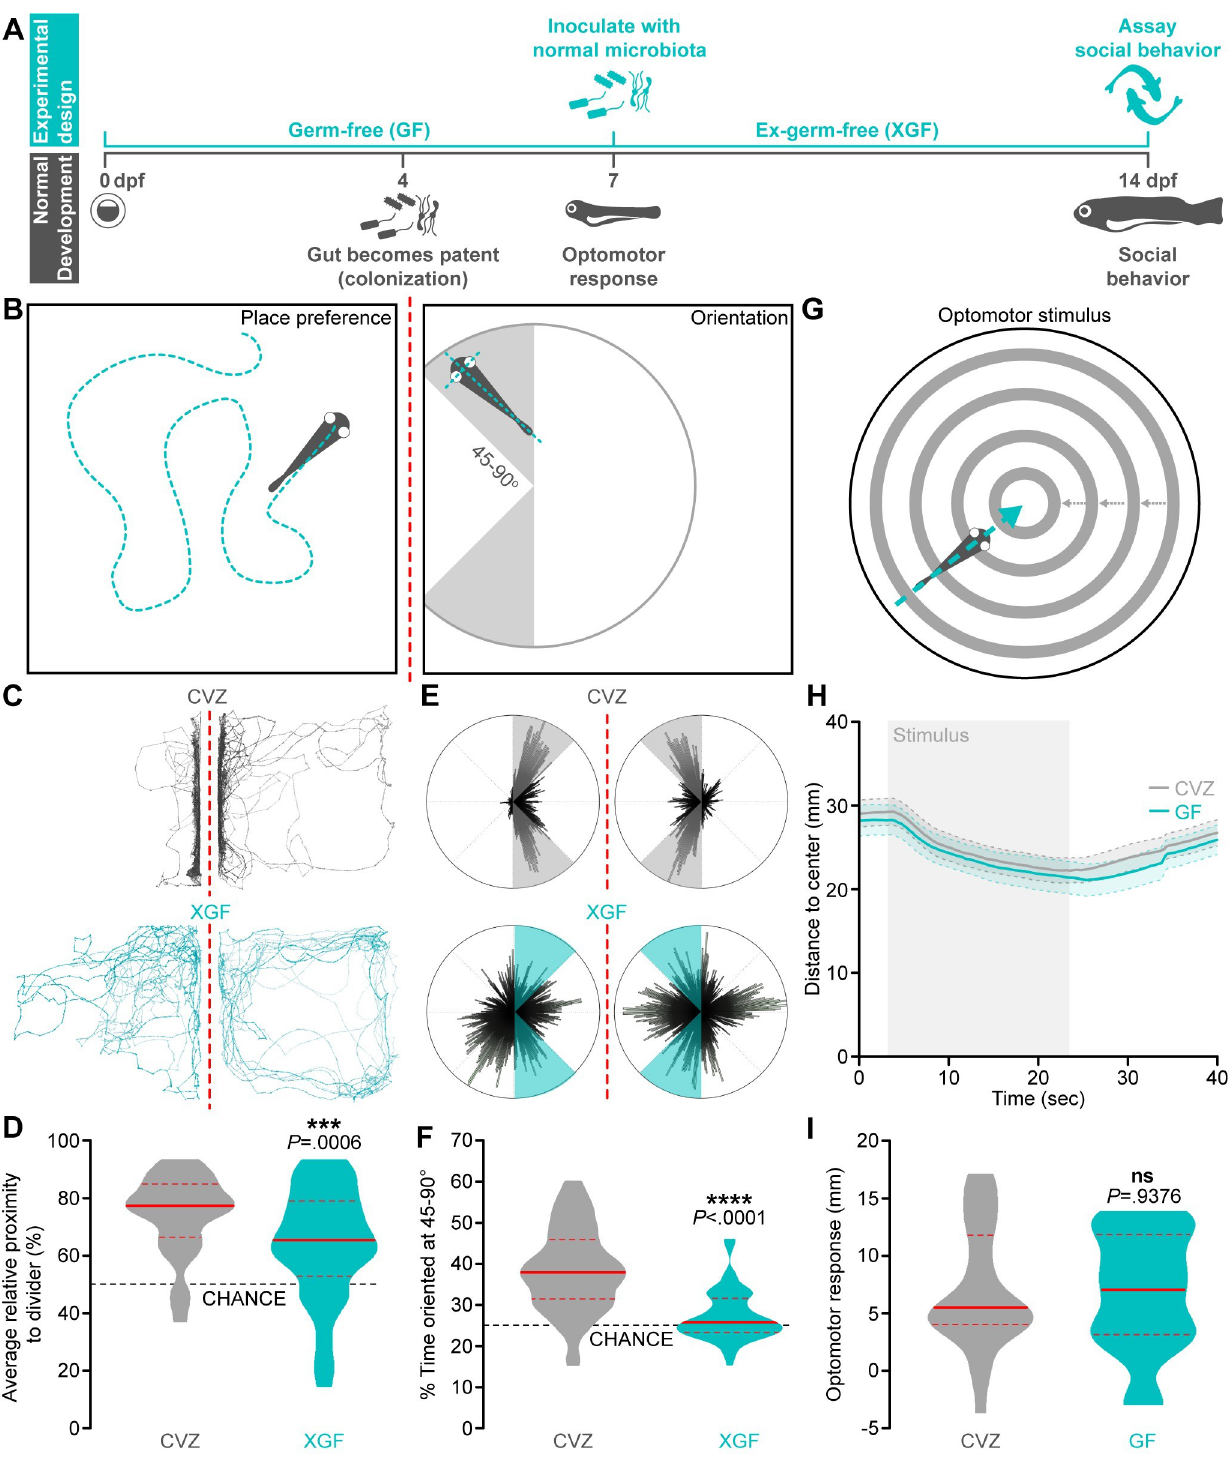
Fig 1. The microbiota promotes zebrafish social behavior. ( A ) Experimental design timeline. ( B ) Zebrafish social behavior is assessed by measuring place preference (left) and body orientation (right) in paired fish separated by a transparent divider (dotted red line). ( C - F ) Social behavior is reduced in 14 dpf XGF larvae relative to CVZ siblings. Traces ( C ) and 360˚ body position polar plots ( E ) of representative CVZ (gray) and XGF (aqua) larvae during social behavior. Average relative proximity to the transparent divider ( D ) and percent of time oriented at 45–90˚ ( F ) are significantly reduced in XGF ( n = 67) larvae relative to CVZ controls ( n = 54 larvae; Mann–Whitney U test). ( G ) Sensorimotor integration is assessed by measuring distance traveled in response